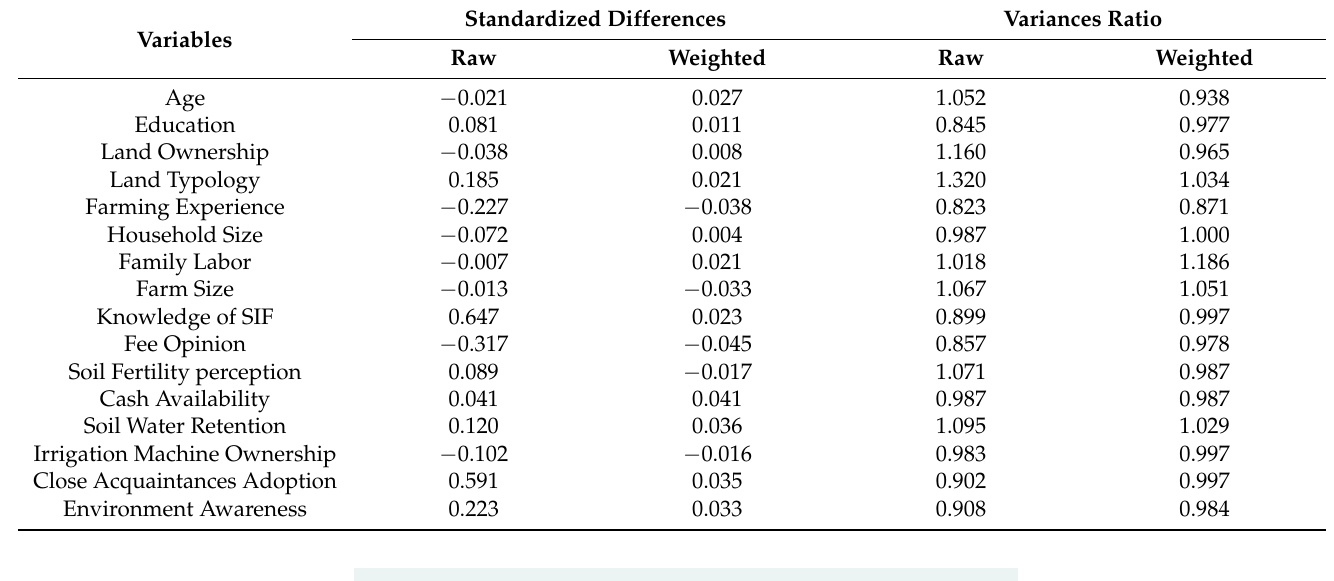
Table 4. Covariates balancing summary.